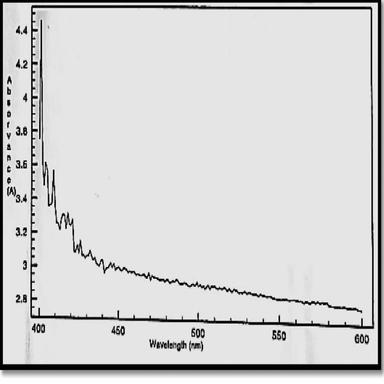
UV–Vis Spectrophotometer reading of aluminum oxide nanoparticles.